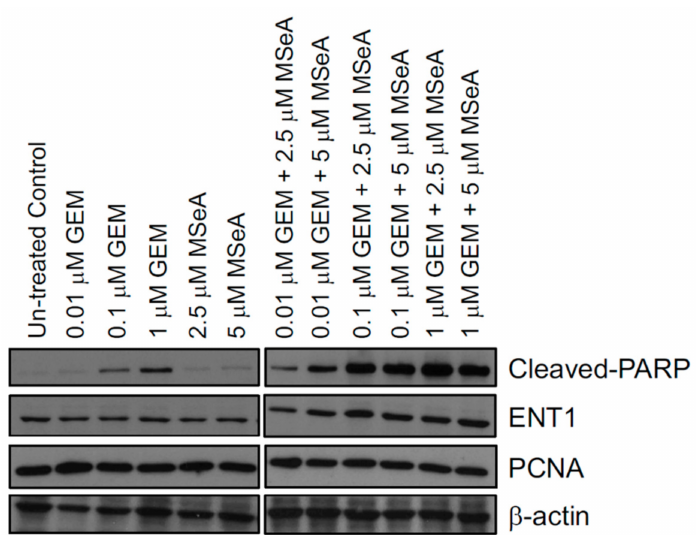
Figure 3. Effect of MSeA and Gemcitabine (GEM) individually and in combination on markers for apoptosis, proliferation, and ENT1 in BxPC-3 cells following 24 h treatment (n = 1). Combinations showed an increase in cleaved PARP protein expression as well as ENT1 protein expression and a moderate decrease in